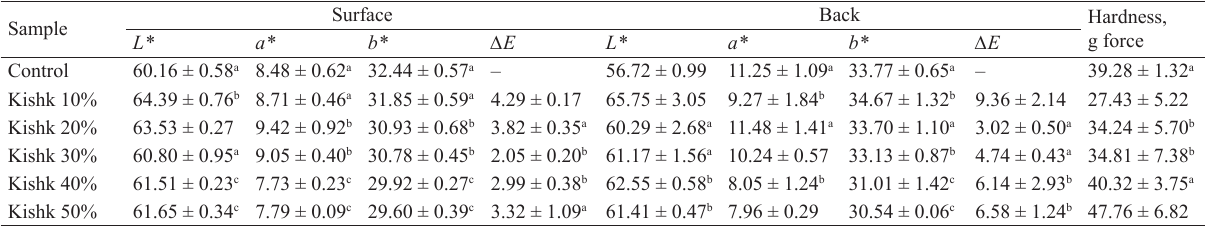
Values are the mean ± SD of three replicates. Mean followed by different letters in the same column differs significantly ( P ≤